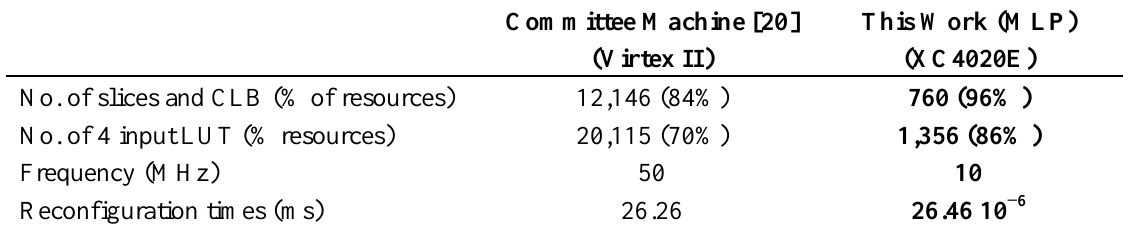
Table 8. Implementation results on Xilinx Virtex II and XC4020E FPGA chip. Committee machine stands of MLP, RBF, KNN, GMM and PPCA